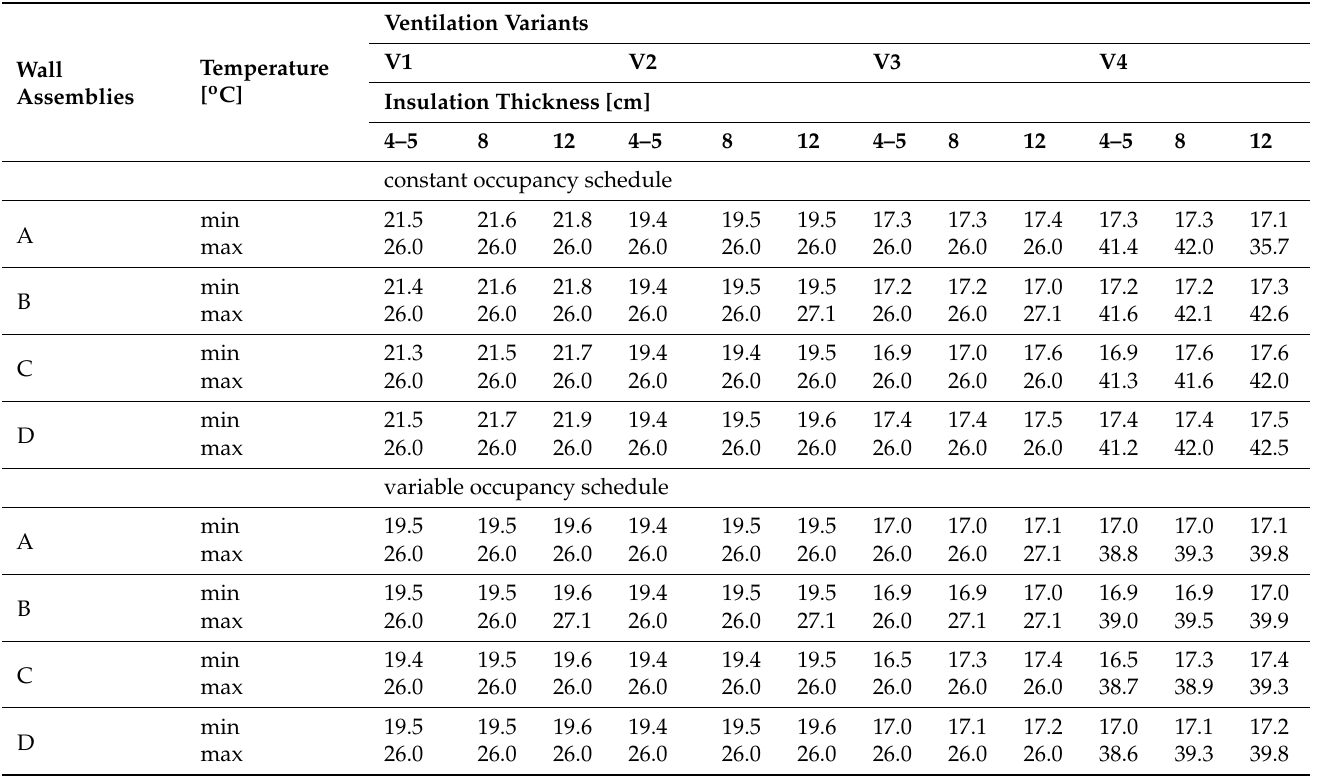
Table 5. Maximum and minimum values of temperature on the inner surface of the wall.